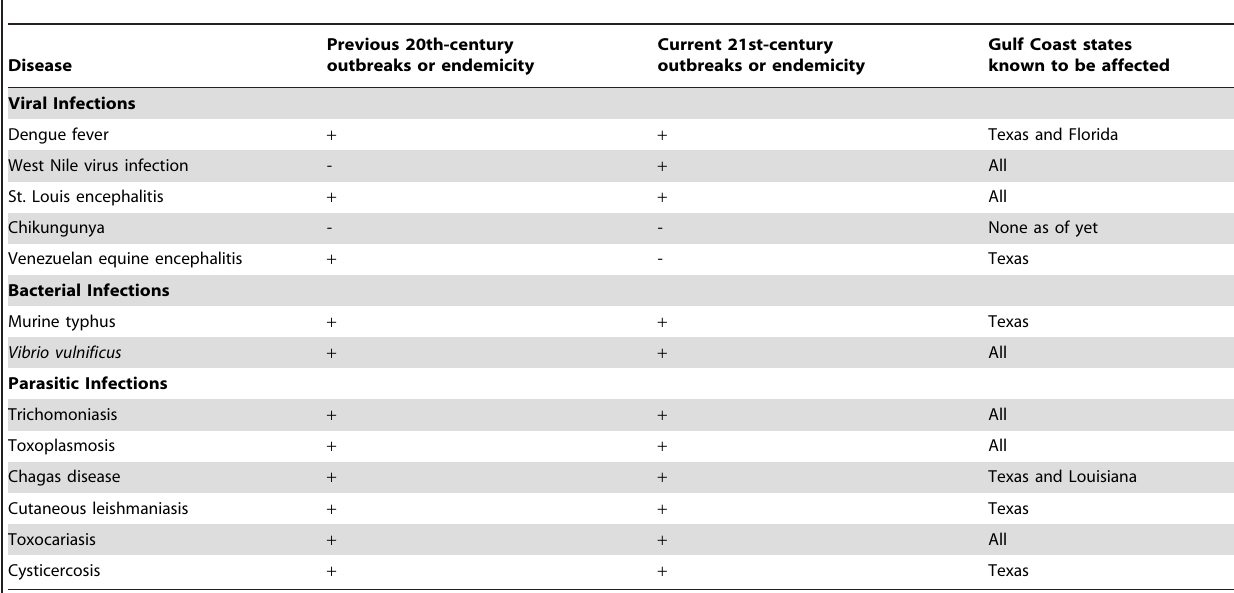
Table 1. Actual or potential neglected tropical disease threats to the US Gulf Coast. Disease